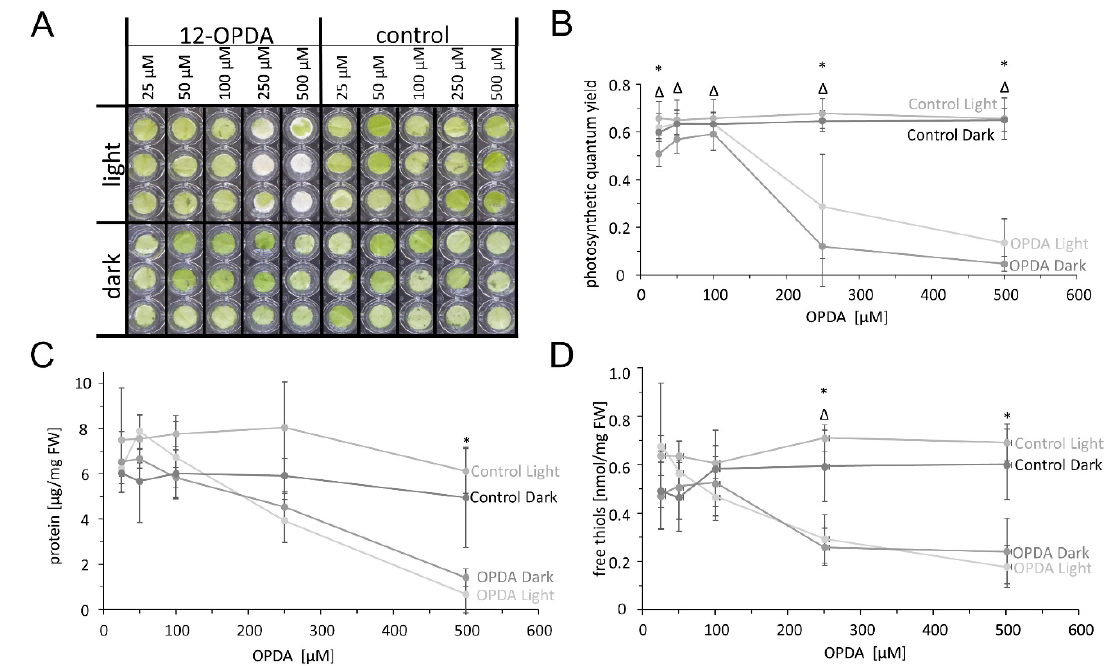
Figure 12. Concentration-dependent effect of OPDA on leaf disc metabolism. ( A ) Exemplary phenotype documentation after 24 h continuous light or darkness. ( B ) Changes in photosynthetic quantum yield of PSII in response to treatment with OPDA. Photosynthetic quantum yield was determined by chlorophyll a fluorescence analysis using the Mini-PAM. Data are means ± SD ( n = 24). ( C ) Protein and ( D ) free thiol contents were measured after the treatment. Data represent means ± SD of n = 3. * and Δ mark significant differences to control in light and dark, respectively, as determined by t -test ( p < 0.05).